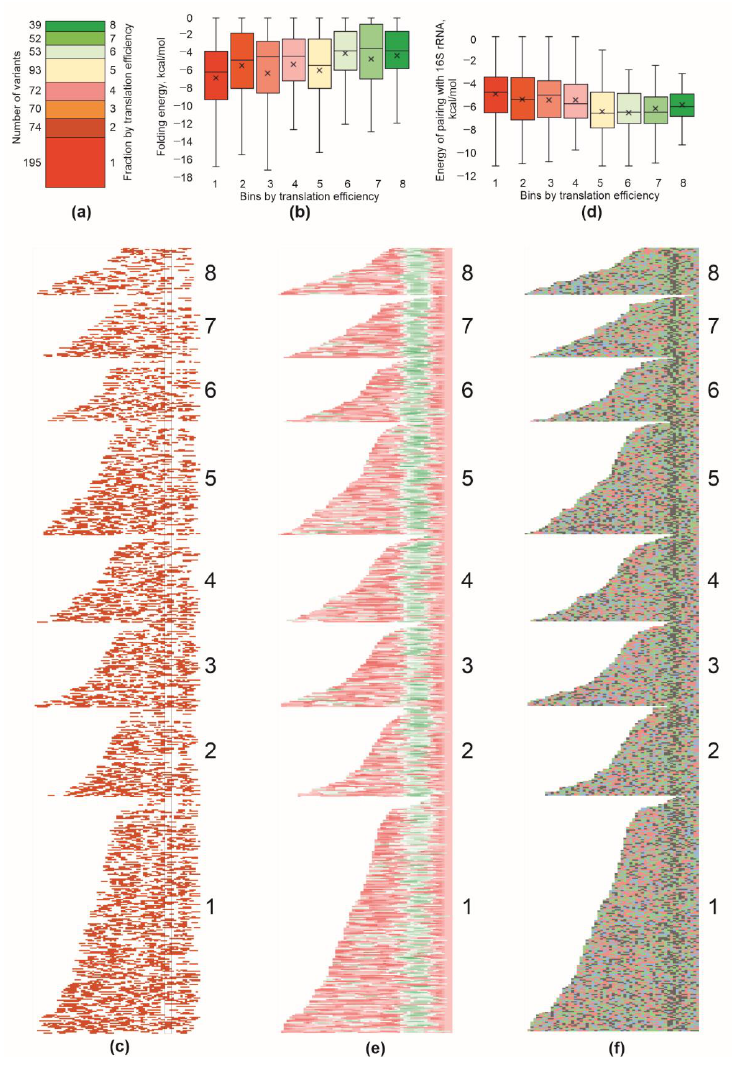
Figure 2. Properties of 5′ -UTR sequences detrimental to translation efficiency. ( a ) Number of 5′ -UTR variants that fell into each bin with translation efficiency (shown on the right side). Exact numbers of variants are indicated left to the bars. ( b ) Distribution of the folding energy of the mRNA region encompassing 5 (cid:48) -UTR and 16 nucleotides of the coding area in the bins sorted with translation efficiency. ( c ) Distribution of nucleotides involved in secondary structures. Each line corresponds to a particular mRNA part from the 5 (cid:48) -end to the position +16 to the beginning of the open reading frame. Location of the ATG start codon is shown with black lines. Red squares correspond to the nucleotides which were paired, white to the single-stranded nucleotides. All mRNAs were aligned with their 3 (cid:48) edge. Sequences were sorted with translation efficiency (bins are indicated on the right side) and length (within each bin). ( d ) Distribution of the maximal interaction energy of the 5 (cid:48) -UTR with the anti-Shine–Dalgarno region of the 16S rRNA in the bins sorted with translation efficiency. ( e ) Distribution of SD sequences along 5 (cid:48) -UTRs tested. Each line corresponds to a particular mRNA 5 (cid:48) -UTR. Color indicates an energy of interaction within an 8 nt sliding window of mRNA with the 16S rRNA 3 (cid:48) terminal region. Green corresponds to the efficient interaction, while red to no interaction. Principle of mRNA sorting was the same as in panel ( c ). ( f ) Nucleotide composition of the 5 (cid:48) -UTR sequences sorted with translation efficiency. Each line corresponds to a particular mRNA 5 (cid:48) -UTR. Blue squares correspond to C, red to U, green to A and grey to G. Principle of mRNA sorting was the same as in panels ( c , e ). See Supplementary Figure S1 for the presentation of the same data as sequence logo [13]. For panels ( b – d ), quartile ranges are shown as solid bars (25% to 50%) and thin lines (0% to 100%). Horizontal line corresponds to median, while cross to the